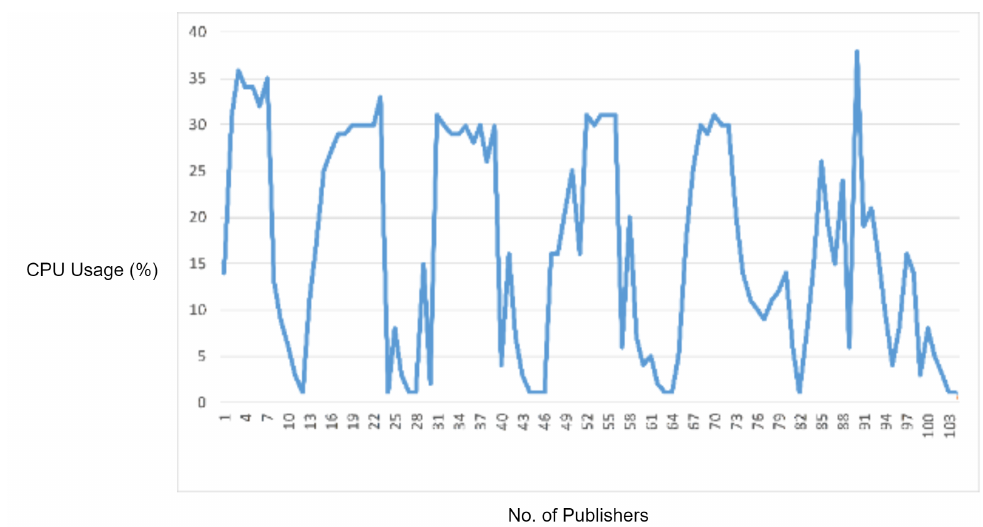
Figure 13. CPU usage captured while testing the miscellaneous